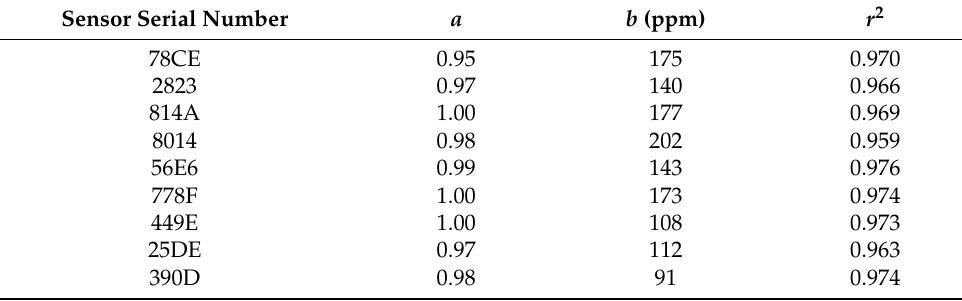
Table 5. Correction function obtained from the benchmark test conducted in